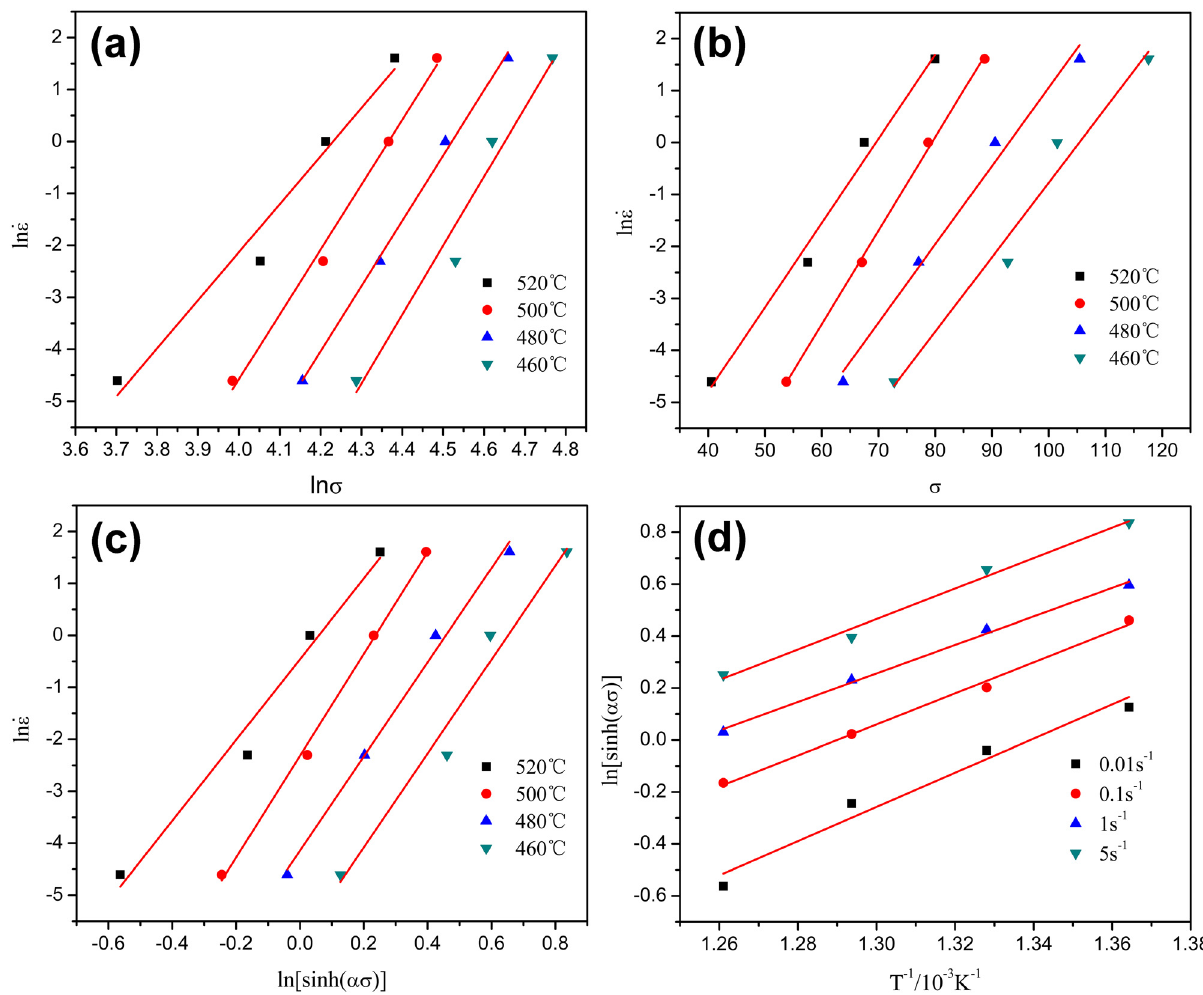
Figure 6: Scatter diagrams and linear regression fi ts: ( a ) σ